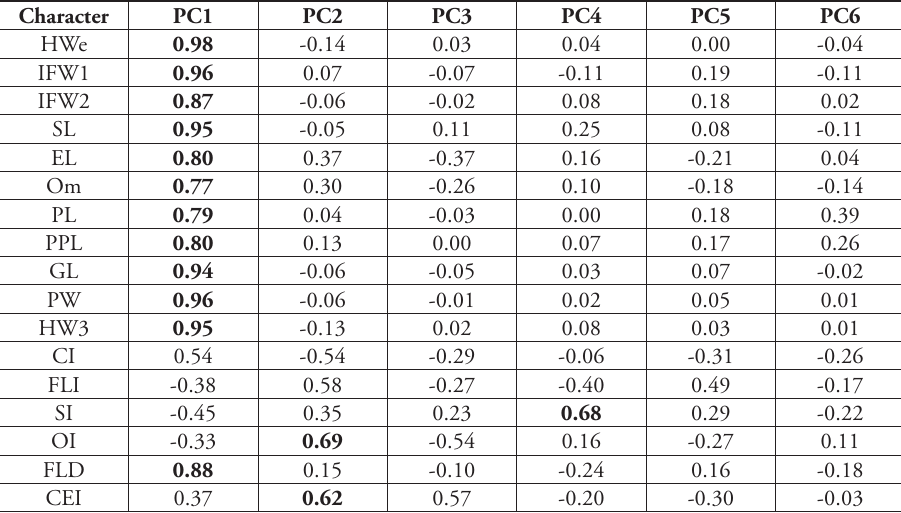
Table 2. Principal component analysis. Character loadings of the first six principal components for all species. The values above 0.6 are indicated in bold